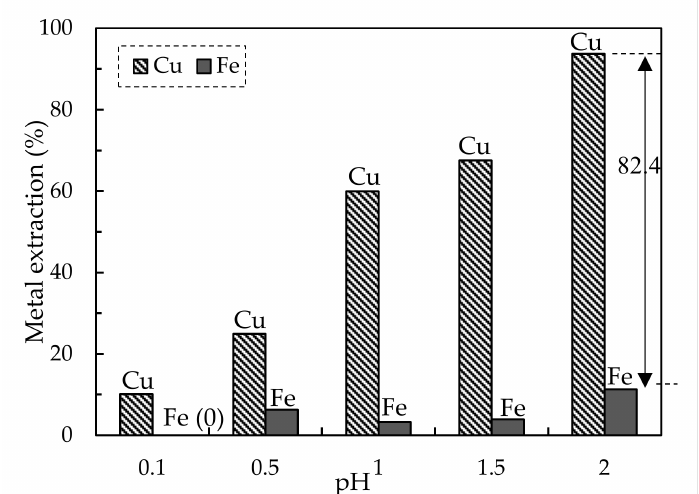
Figure 8. The extraction behavior of metals as a function of pH (Conditions: LIX-84I/Kerosene mixing ratio 1, organic/aqueous phase ratio 0.2, agitating speed 600 rpm, and contact time 15 min).